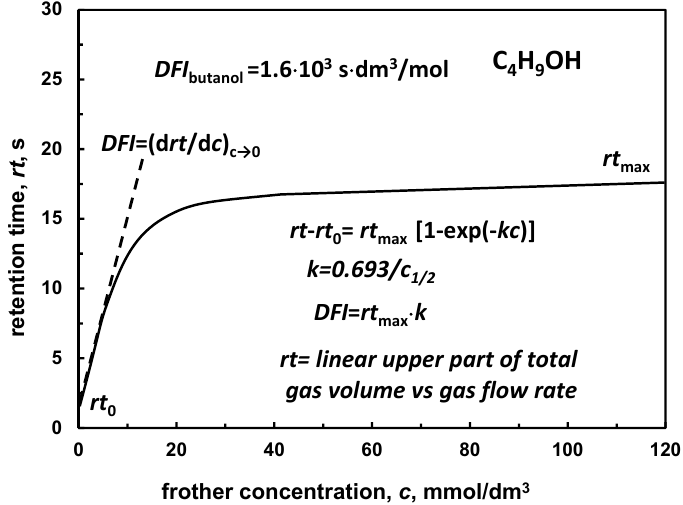
Figure 8. Determination of DFI (based on [50]).